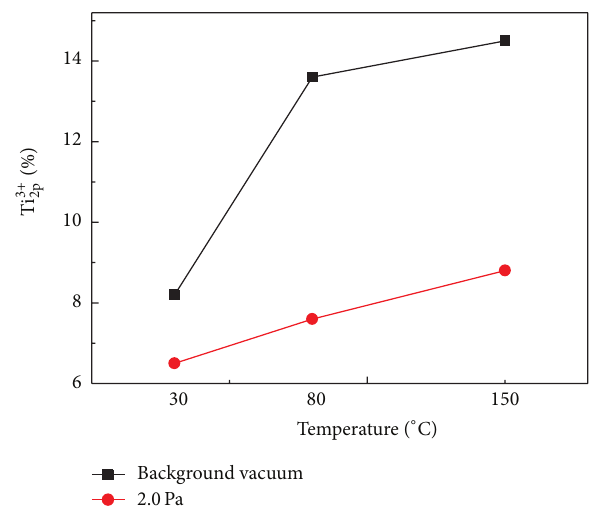
Figure 5: The percentage of Ti 3 + 2p components as functions of TiO 𝑥 deposition